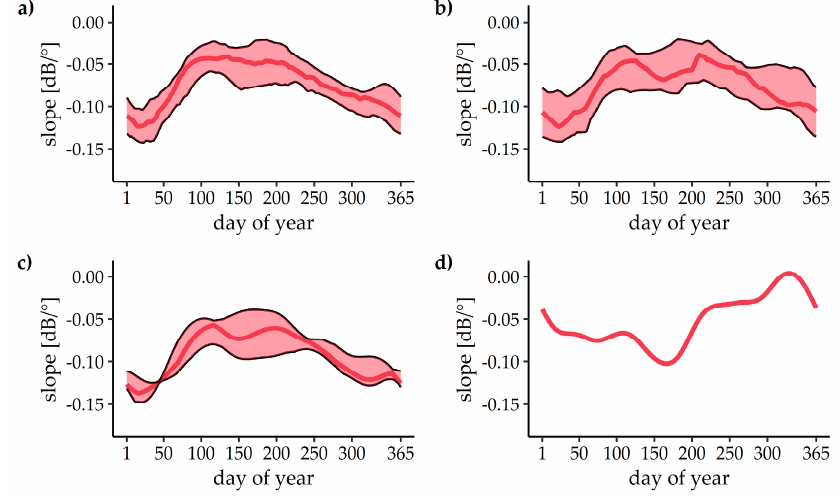
Figure 5. Boxplot of Spearman temporal correlation coefficients between σ 0 and WTD with median (bold line), quartiles and mean (diamond) value (n = 60 monitoring wells). Whiskers display the range of 1.5 times the interquartile range above the third quartile or below the first quartile with outliers beyond. σ 0 θ (VV) constant: VV polarization normalized with a constant slope, σ 0 θ (VV) cross-over: VV polarization with cross-over angle correction, σ 0 θ (VV pcor PD) constant: VV polarization normalized with a constant slope and using partial correlation analysis with PD as controlling variable, σ 0 θ (VH) constant: VH polarization normalized with a constant slope. Results are grouped for correlations of ascending, descending and all orbits.